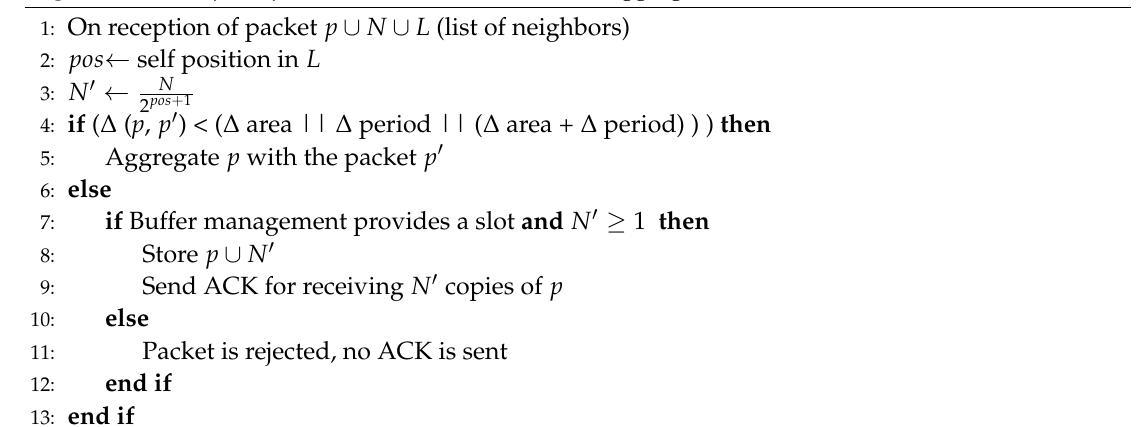
Algorithm 3 Reception phase : IoB-DTN based on data